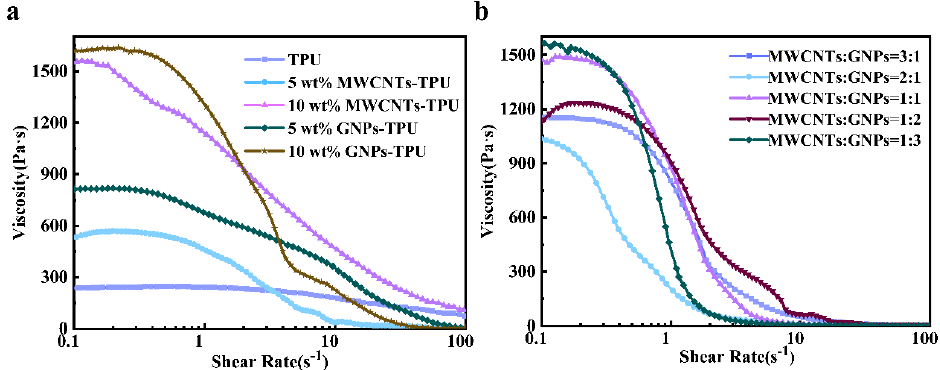
Figure 2. Rheological properties of different components and different filling proportions of ink. ( a ) Viscosity curves of TPU inks filled with pure TPU and single component fillers. ( b ) Viscosity curves of composite inks at room temperature using a total of 10 wt% fillers with different proportions of MWCNTs and GNPs fillers (MWCNTs: GNPs = (3:1, 2:1, 1:1, 1:2, 1:3)). As shown in Figure 2b, the viscosities of the five inks with different ratios show ob- vious shear thinning behavior in a certain range of shear rate, which can ensure smooth extrusion from the head of the needle. However, there is no specific rule for the initial viscosity of two-component filler printing inks, and their initial viscosities do not show an obvious change pattern with the increase in a component percentage. The experimental results demonstrate that the ink with MWCNTs: GNPs = 1:3 has the highest initial viscos- ity, while the ink with MWCNTs: GNPs = 2:1 has the lowest initial viscosity. The main reason for this result is the interaction of two fillers with different shapes. Specially, the morphology of nanocomposites is a complex issue as agglomeration, exfoliation, interac- tions, etc., might exist between particles, which may lead to irregular variations in the initial viscosity. In addition, the applied solvent is DMF with a certain volatility, which partially affects the viscosity determination when performing the rheological testing of printing inks on a rotational rheometer. However, during the printing process, the upper part of the syringe used to hold the printing ink is closed, and so the solvent does not evaporate in the syringe during the printing process.